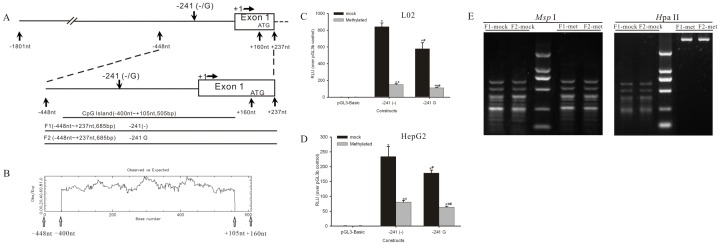
Effect of plasmid DNA methylation on PPP2R1A promoter activity.
A. The PPP2R1A genomic reference sequence (with GenBank accession no. AC 010320) was used with the transcription start site (TSS) set as nucleotide +1. The variant identified in the current study, −241 (−/G) (rs11453459), is located in the PPP2R1A promoter region (−1801 nt to +237 nt). The two fragments, designated as 2R1Ap-Fs, including F1 ((−)−241) and F2 ((G) −241), are located in the PPP2R1A proximal promoter (−448 nt to +237 nt, 685 bp). B. The CpG islands of the 5′-flanking region of PPP2R1A. The region from −400 nt to +105 nt was identified as a CpG island using the CpG finder at EMBL (http://www.ebi.ac.uk/) and the following parameters: CpG length >200 bp, G+C >50% and a “CpG value” of at least 0.6. C. The PPP2R1A promoter activity with various methylation statuses was measured by Dual Luciferase Assays in L02 cells. The promoter activity in the luciferase reporter assays decreased significantly following plasmid DNA methylation. Compared with the basal activity of the pGL3-Basic control (Ctrl, which the relative luciferase activity was given a value of 1 RLU), the promoter activity of all constructs was increased by statistically significant levels (∗ P<0.01). Compared with the luciferase activity of unmethylated pGL3b-2R1Ap-241(−) construct or −241G construct, the promoter activity of the methylated −241(−) construct or −241G construct was decreased by statistically significant levels (a
P<0.01 and b
P<0.01, respectively). Compared with the luciferase activity of the methylated F1 construct with −241 (−), the promoter activity of the methylated F2 construct with −241 G was decreased by statistically significant levels (#
P<0.01). D. The PPP2R1A promoter activity with methylation was measured in HepG2 cells. The promoter activity in the luciferase reporter assays decreased significantly following plasmid DNA methylation. Compared with the basal activity of Ctrl (given as 1 RLU), the promoter activity of all constructs was in significant higher levels (∗ P<0.01). Compared with the activity of unmethylated pGL3b-2R1Ap-241(−) construct or −241G construct, the promoter activity of the methylated −241(−) construct (a
P<0.01) or −241G construct (b
P<0.01) was decreased significantly respectively. Compared with the luciferase activity of the unmethylated or methylated pGL3b-2R1Ap-241(−) construct, the promoter activity of the −241G construct was decreased by statistically significant levels (#
P<0.01). E. Methylation status was confirmed by comparing the plasmid’s digestion profile with HpaII (methylation sensitive) and MspI (methylation insensitive) restriction enzyme. A series of PPP2R1A luciferase reporter constructs and its empty vectors were treated with or without M. SssI and its substrate SAM. The results represent the mean ± SD of three independent experiments.